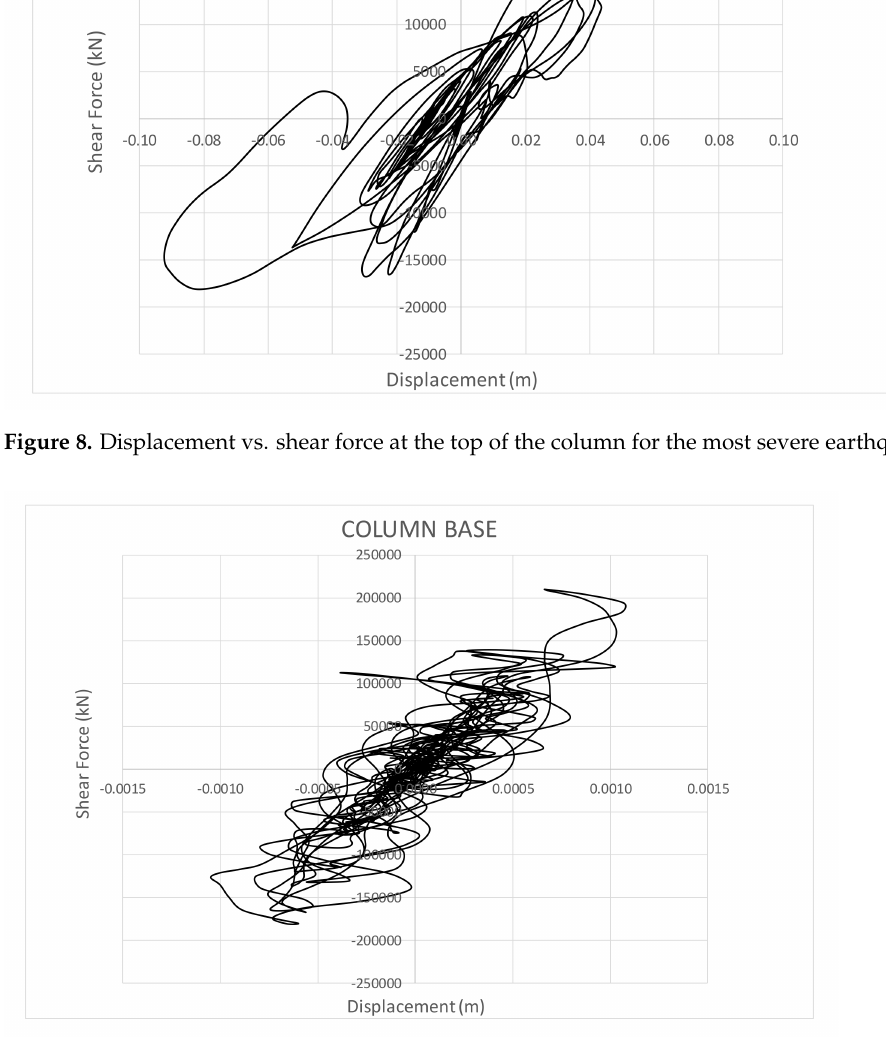
Figure 9. Displacement vs. shear force at the base of the column for the most severe